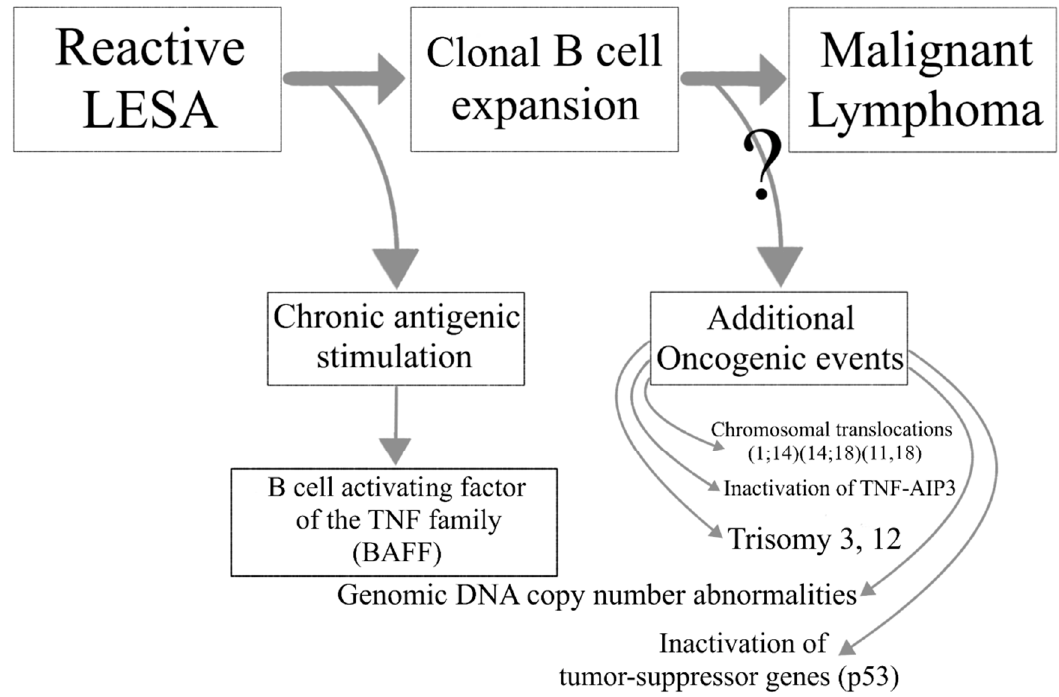
Figure 2. The transition from lymphoepithelial sialadenitis to malignant lymphoma.